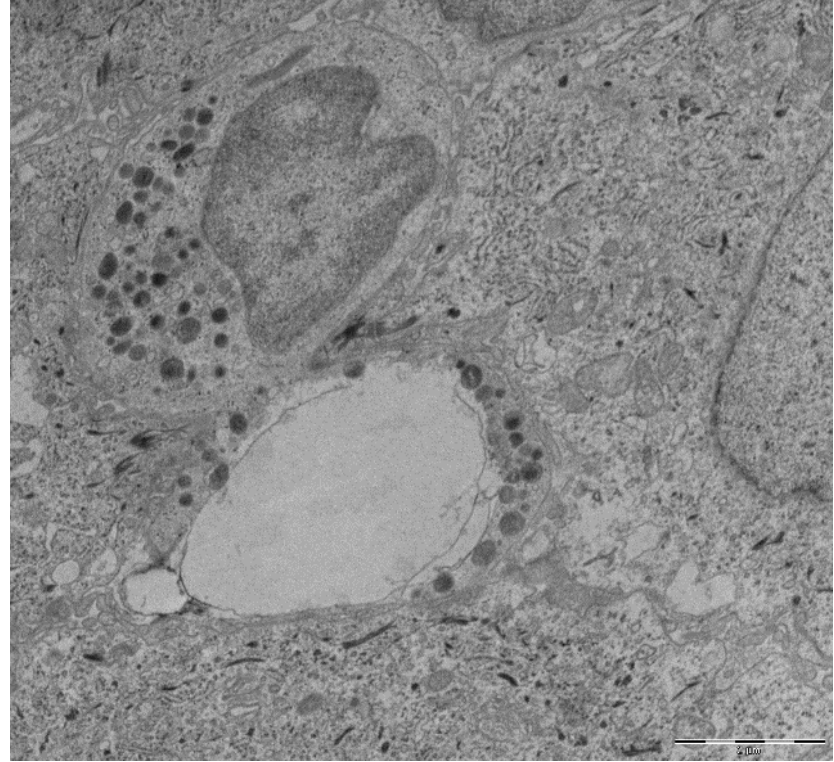
Figure 1. Transmission electron microscopy micrograph from a gingival tissue sample with periodontitis. An emptied disrupted neutrophil alongside an intact one are shown. Scale bar, 2¦Ìm.